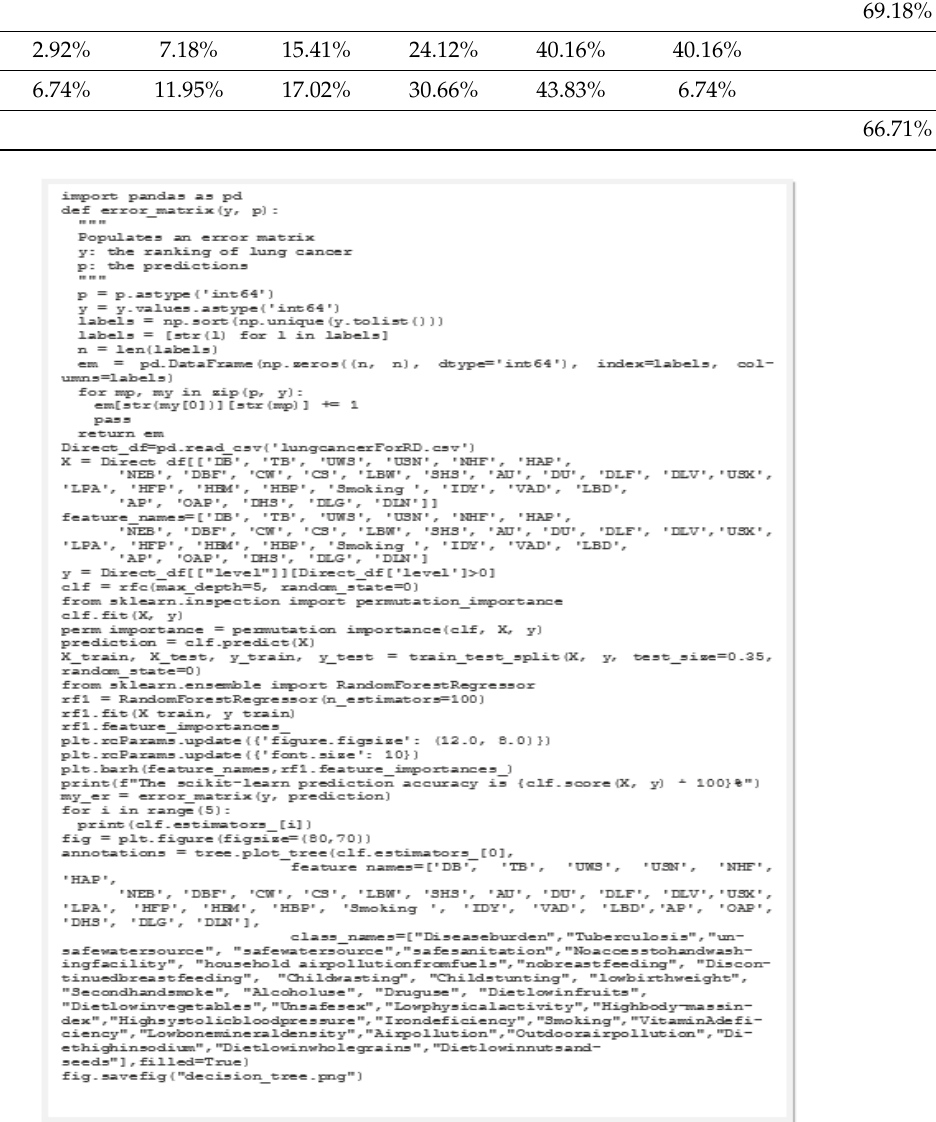
Figure 3. Python codes used in the FRM.